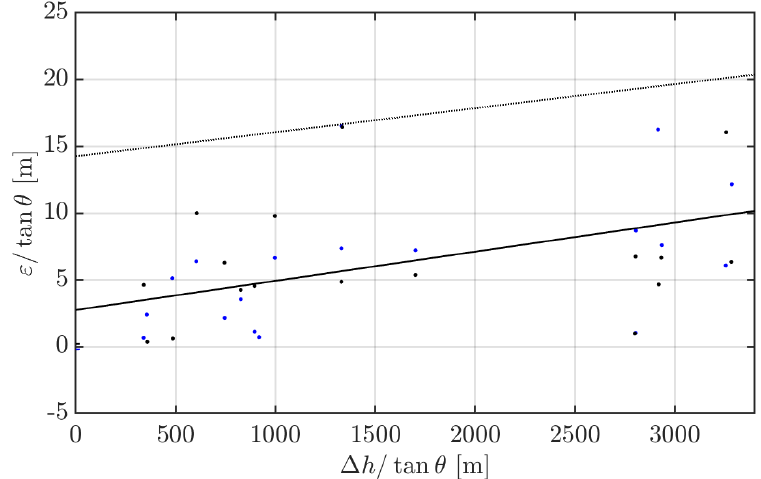
Figure 20. Absolute errors measured in the Andes and Sentinel range, relative to the tangent of the solar elevation θ . Measurement errors represented as blue points correspond to nadir-looking bands and black points to backward-looking bands. The solid black line shows the best linear fit, and the dotted black line represents the a priori total error estimate detailed in Table